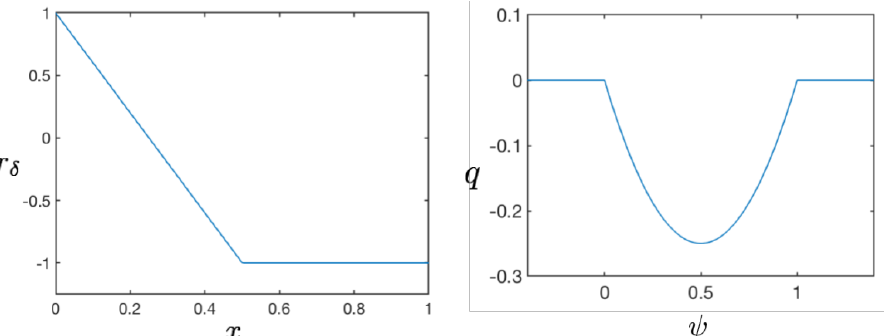
Figure 9. Components r δ ( x ) and q ( ψ ) of the auxiliary function g δ ( x , ψ ) = r δ ( x ) q ( ψ ) from (21e) with δ = 0.5 and Γ = { 0 } . As x → Γ , r δ ( x ) → 1 and g δ ( x , ψ ) ≥ 0. In contrast, away from Γ , we have r δ ( x ) ≈ − 1 and g δ ( x , ψ ) ≥